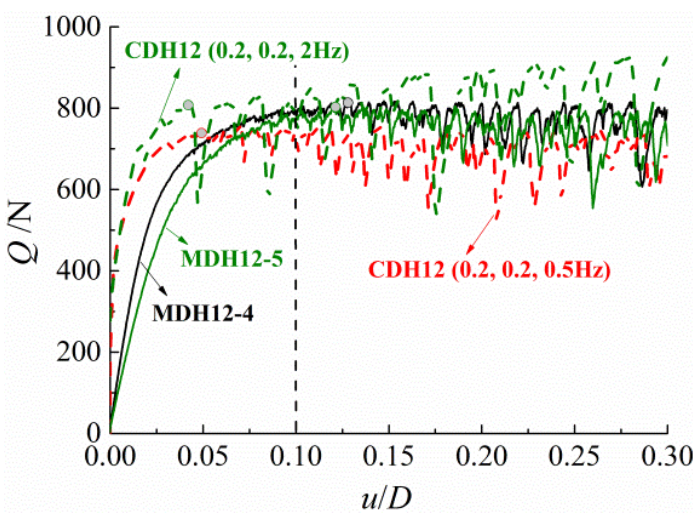
Figure 18. Post-cyclic monotonic and monotonic responses for different frequencies.